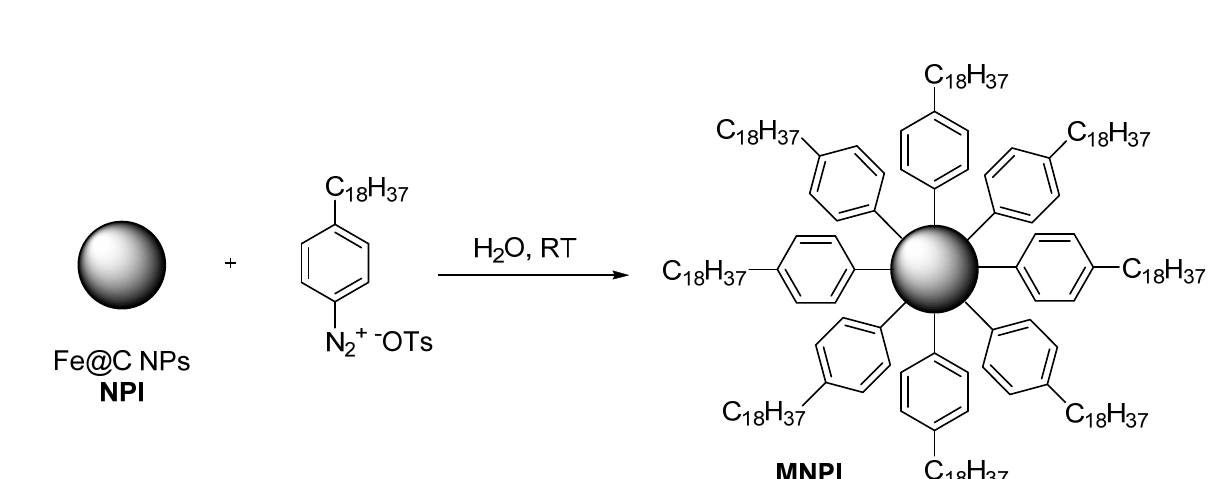
Figure 1. The surface modification of Fe@C NPs by lipophilic organic groups mimicking atheroprotective biomimetic HDL.